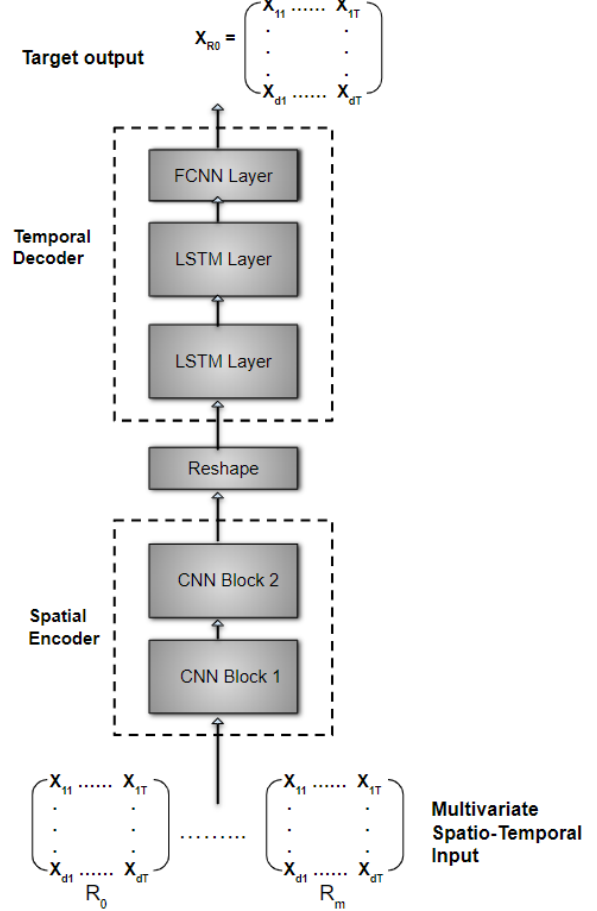
Figure 4. The detailed architecture of the hybrid autoencoder framework: It has a Convolutional Neural Network (CNN)-based spatial encoder and a Long Short-Term Memory (LSTM)-Fully Connected Neural Network (FCNN)-based temporal decoder.